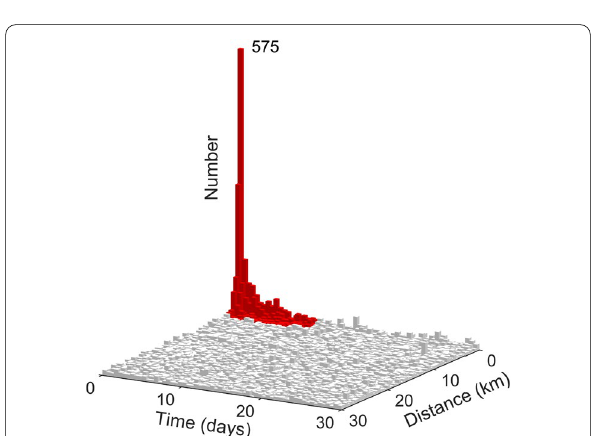
Fig. 5 The time–space distribution of all the earlier smaller earthquakes prior to the 2066 mainshocks. Red bars (within 10 days and 3 km) are defined to be the foreshocks in this study. White bars are the random background